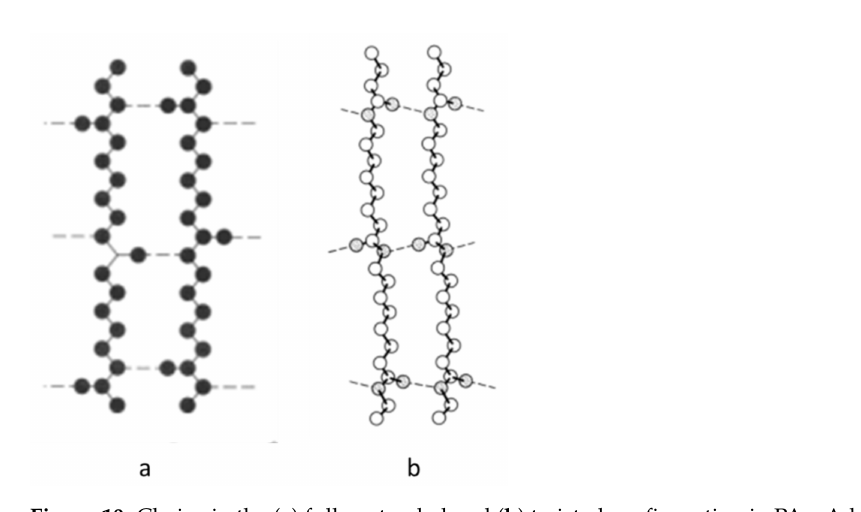
Figure 10. Chains in the ( a ) fully extended and ( b ) twisted configuration in PAs. Adapted from [84]. Copyright 1973 John Wiley and Sons.